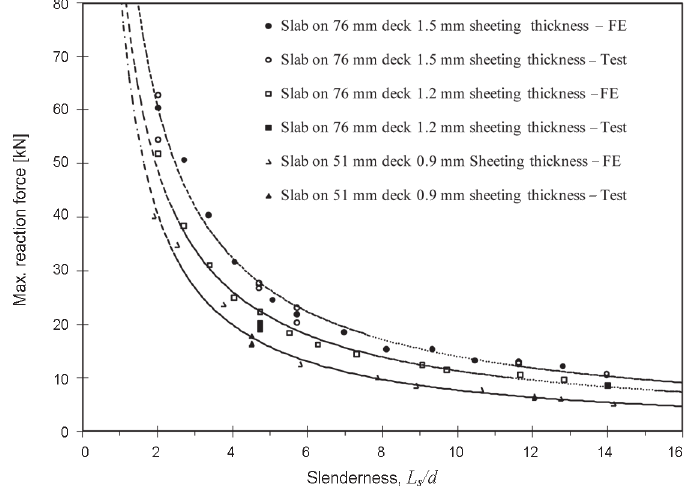
Fig. 1. Variation in the maximum reaction forces with respect to the slenderness of slab from the bending tests and FE analyses of simply supported composite slabs with a trapezoidal profiled steel deck (Abdullah, Easterling 2007,